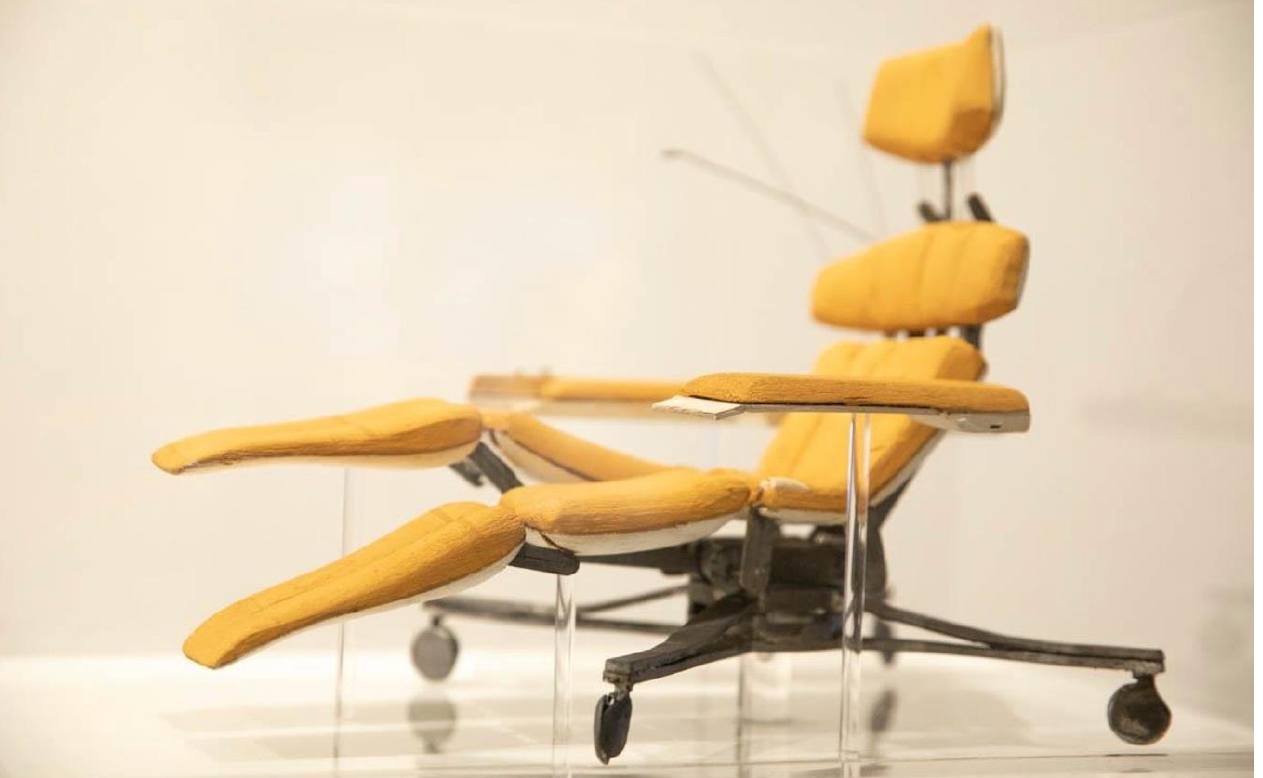
Figure 5. Takis Ch. Zenetos, physical model for the “all-purpose furniture.” Image courtesy of the Takis Ch. Zenetos Ar- chive.